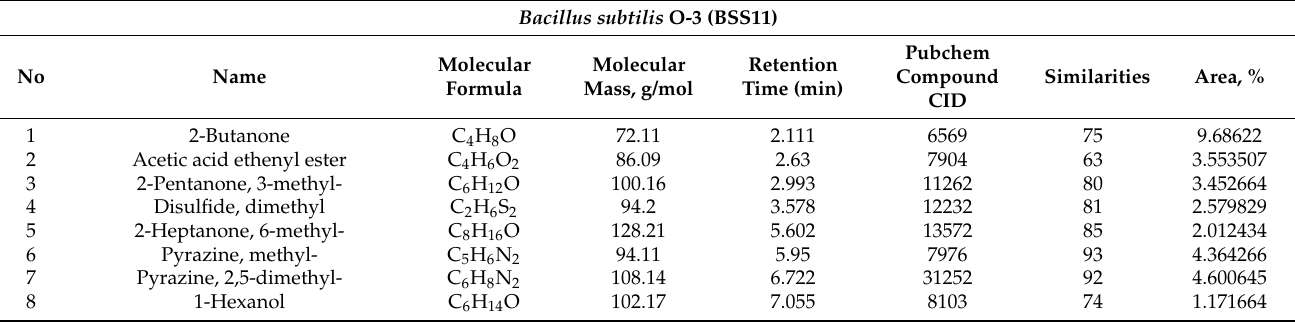
Table 4. The main constituents of bacterial extract BSS11 identified through a GC–MS